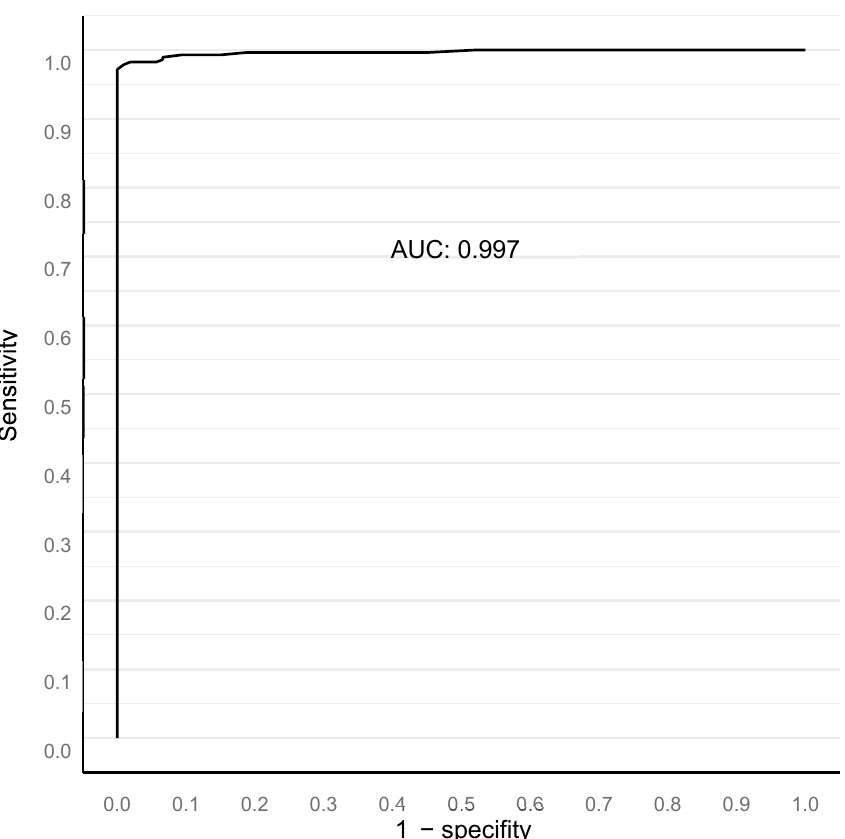
Figure 3. ROC AUC analysis for benign versus malignant compared to clinical diagnosis at full biopsy session level, with a 15,000 square micron filter applied (see text).